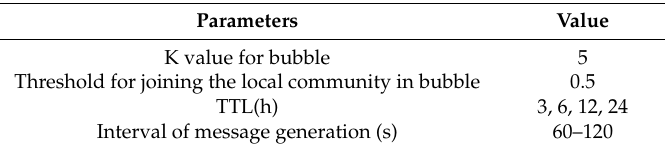
Table 1. Primary Parameters.